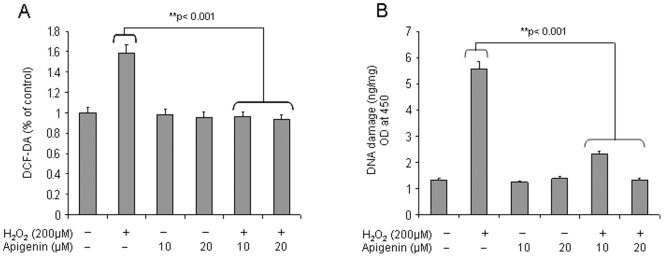
Effect of apigenin on reactive oxygen species (ROS) generation and 8-hydroxy-2′-deoxyguanosine (8-OHdG) levels with H2O2 in transformed human prostate epithelial RWPE-1 cells.(A) ROS assay with DCF-DA on RWPE-1 cells treated with 10 µM and 20 µM apigenin for 16 h followed by 200 µM H2O2 incubation for 6 h. (B) 8-OHdG levels in RWPE-1 cells treated with 10 µM and 20 µM apigenin for 16 h followed by 200 µM H2O2 incubation for 6 h. Bars±SD of experiments performed three times. **P<0.001, compared to H2O2 treated group. Details are described in materials and methods section.